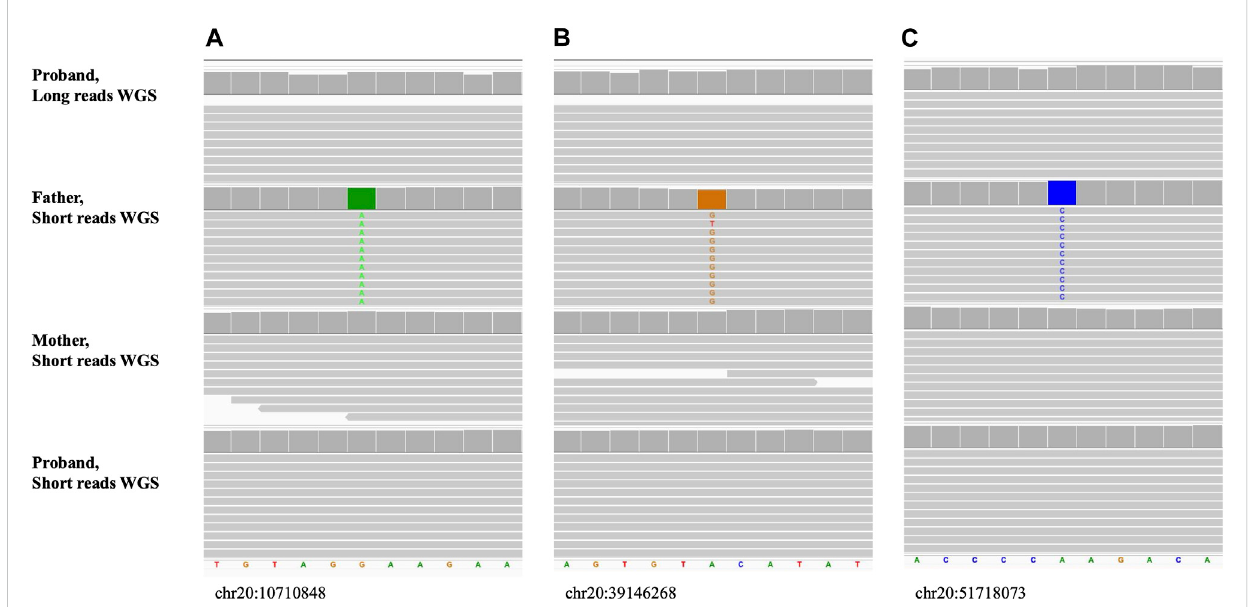
FIGURE 9 Maternal uniparental disomy,UPD(20)mat(Sample_15). Thealignmentview ofthecon fi rmatorylongreadsWGS inproband andoriginal short reads familial trio WGS. Order top to bottom: long reads con fi rmatory WGS in proband, short reads initial WGS in father, mother, proband. Each thick gray horizontal line represents a separate read. String of letters below the panels indicate reference nucleotide sequence, and colored nucleotides over the read sequences stand for the nucleotides not matching the reference. (A – C) Examples of small sequence changes used for UPD con fi rmation. Variants are homozygous alternate in father and reference in mother. Coordinates of the variants on hg38 are shown under each